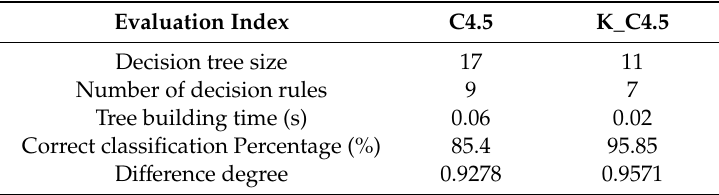
Table 10. Analysis of evaluation in di ff erent algorithms using fault samples.